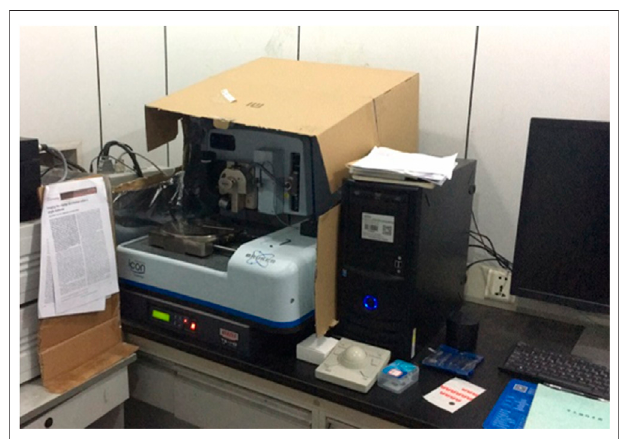
FIGURE 3 | AFM test system.